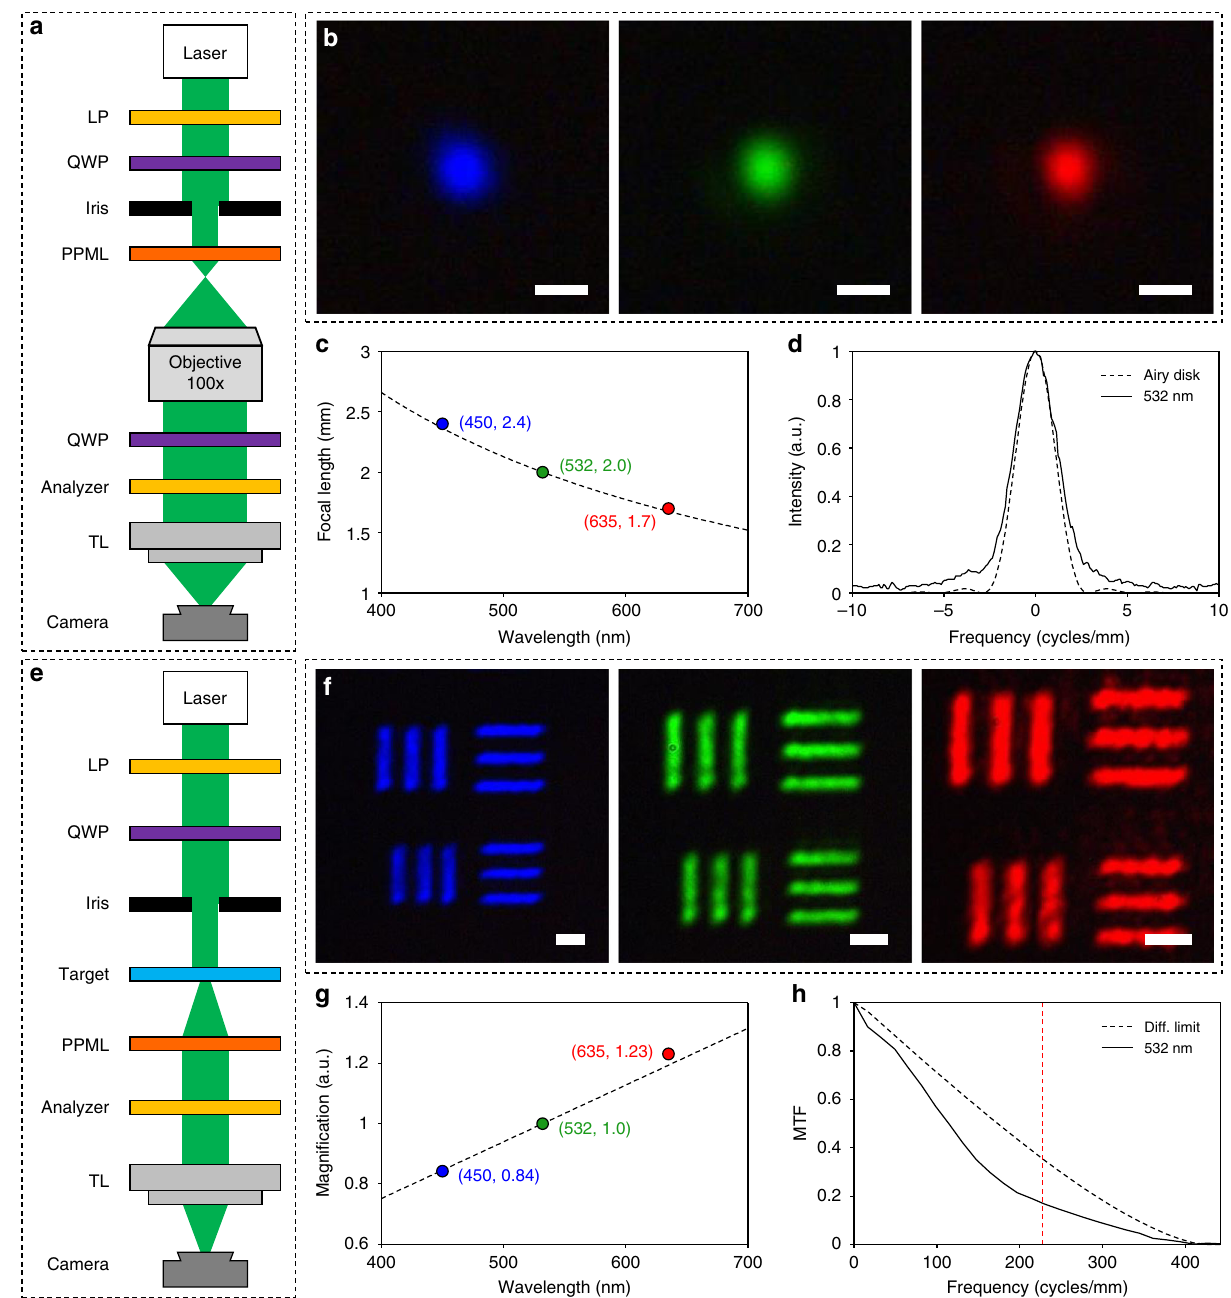
Fig. 6 Optical properties of plum pudding metalens. a Optical setup to characterize the focal spot. LP linear polarizer, QWP quarter-wave plate, TL tube lens, PPML plum pudding metalens. b Captured images of focal spots at wavelengths λ = 450, 532, and 635, respectively. All scale bars: 5 μ m. c Measured focal lengths denoted by three colored circles of 2.4mm at λ = 450nm, 2.0mm at λ = 532nm and 1.7mm at λ = 635nm. Dashed line: theoretical prediction of the focal length f = f d λ d / λ where λ d and f d represent the design wavelength (532nm) and focal length (2mm), respectively. d Comparison of focal spot intensity pro fi les at λ = 532nm. The full width at half maximum (FWHM) of the measured pro fi le is 2.8 μ m that is closely consistent with the FWHM of the airy disk of 2.4 μ m. e Optical setup to evaluate imaging properties of the PPML by using it as an objective lens. The analyzer allows only cross-polarized light to reach the camera. f Captured target images at λ = 450, 532, and 635nm, respectively. The imaging area includes the element 5 and 6 of group 7 in the negative 1951 United States Air Force resolution test chart. All scale bars: 5 μ m. g Comparison of magni fi cation by wavelengths. Dashed line: theoretical prediction of the relative magni fi cation. Colored dots: measured image magni fi cation at each wavelength. h Modulation transfer function (MTF) comparison between the PPML and a diffraction-limited imaging system. Red dashed line: location of the frequency value of 228mm − 1 that is the maximum spatial frequency of the target